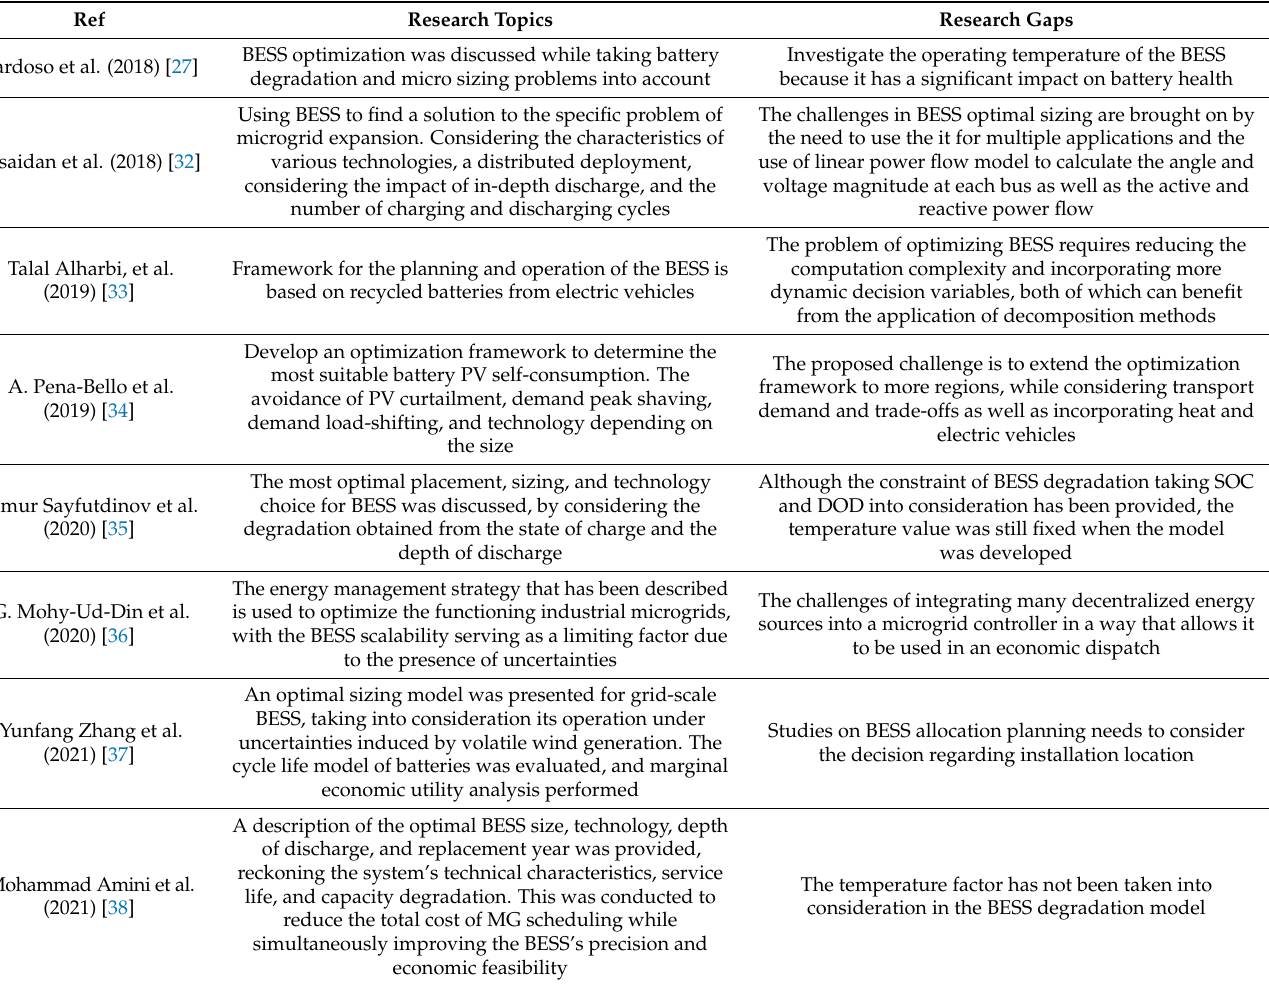
Table 4. Review of a recently published article on BESS